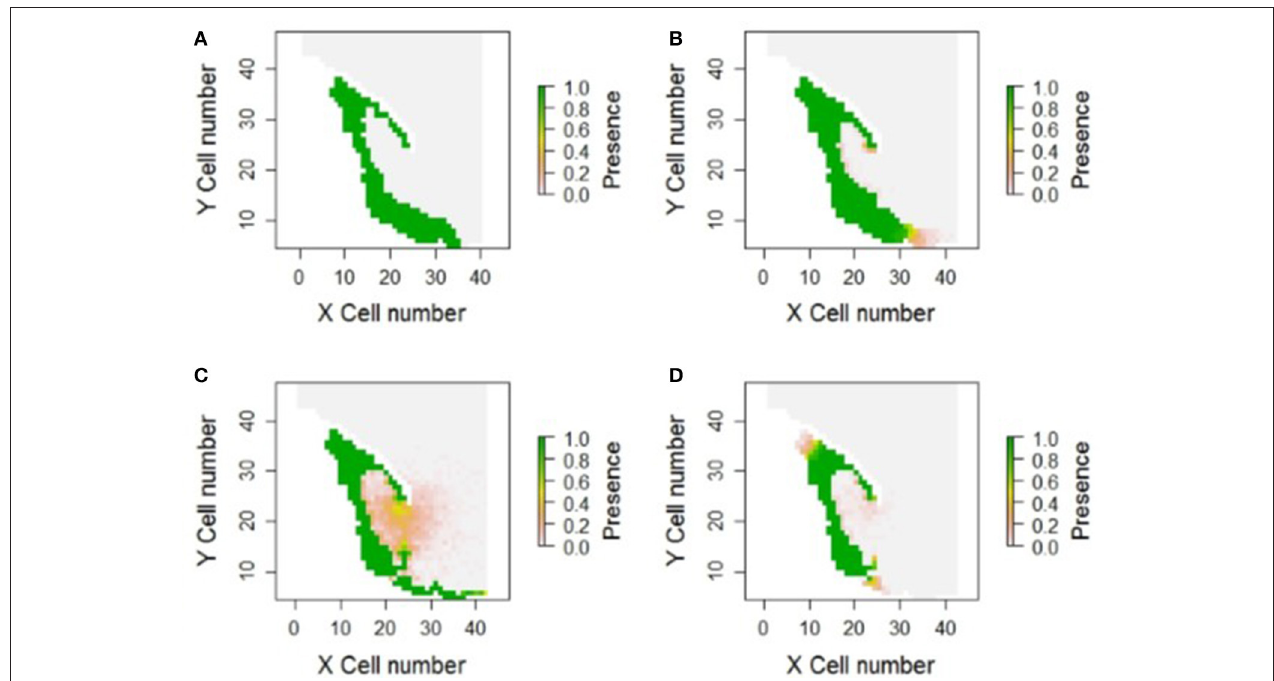
FIGURE 3 | Example model outputs from four different parameter combinations in the Gulf of Gdansk. X and Y cell numbers represent the cell number, or coordinates, on the gridded landscape created for the modeling exercise. Green cells represent a cell that was colonized by populations in each of the 100 repetitions (i.e., 1.0 refers to 100% of repetitions). Model (A) represents the actual goby distribution, and therefore a perfect model output. Model (B) represents an example of an accurate model, whereas (C) represents model over dispersion, and (D) under dispersion combined with dispersion into the wrong